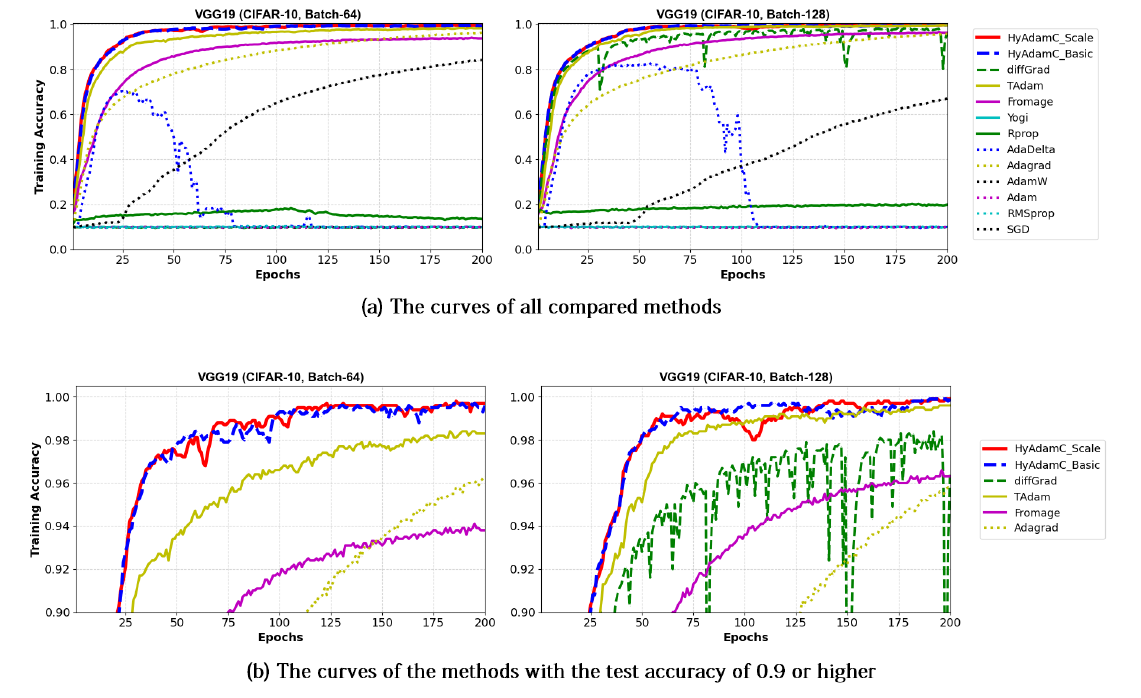
Figure 14. The training accuracy curves of the VGG-19 trained by HyAdamC and other optimization methods in the CIFAR-10 image classification tasks. In this figure, ( a ) shows the training accuracy curves of all compared methods. On the other hand, ( b ) illustrates the plots in which a range of the y-axis of the plots described in ( a ) is zoomed into between 0.9 and